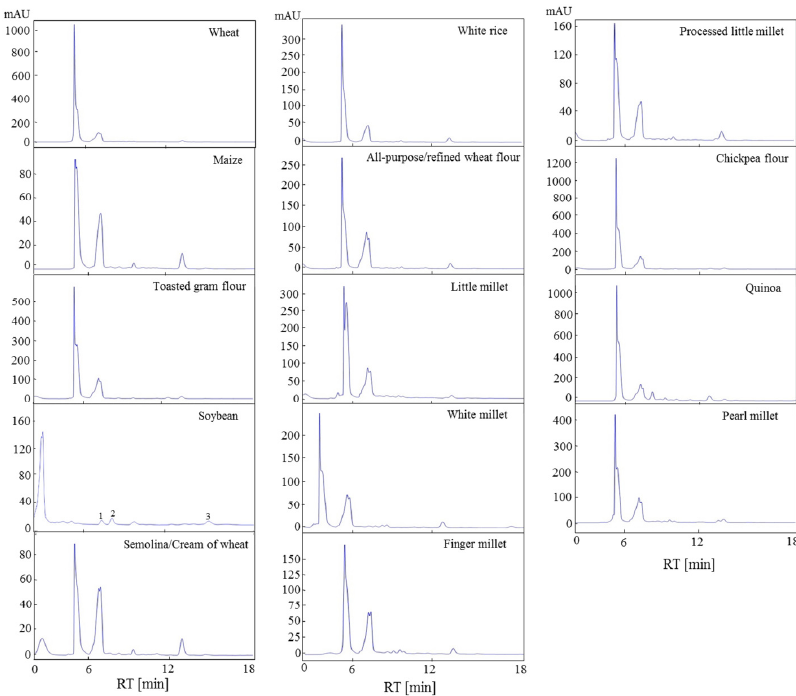
Fig. 3. A typical chromatographic separation of IF extracts from investigated Indian grain flours; Representative HPLC chromatograms showing the separation of ethanol soluble and acid hydrolysable IF extracts from various Indian grain flours. The individual aglycone from each sample was evaluated by peak identification with overlapping retention time (min) of corresponding aglycone